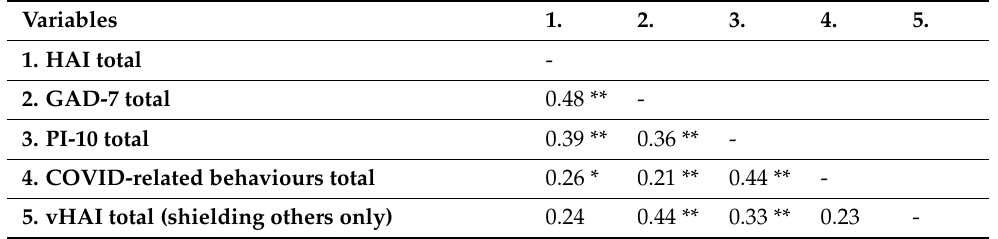
Table 3. Pearson’s correlations between main study